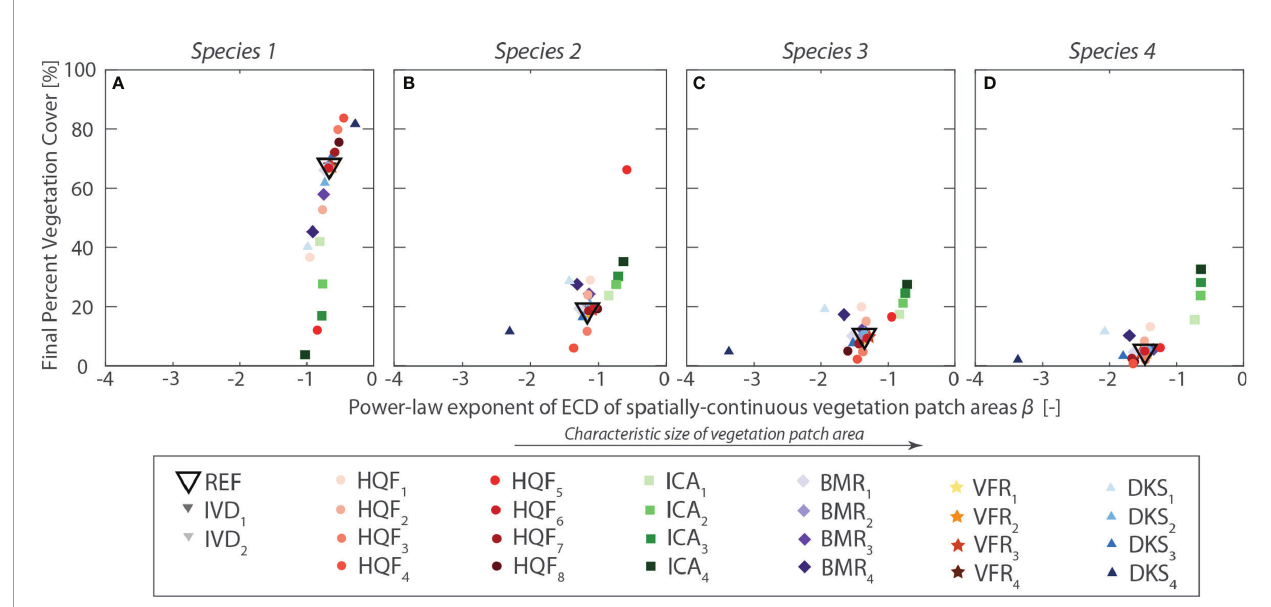
FIGURE 8 | Summary of sensitivity analysis. For each scenario explored in the sensitivity analysis, the average percent cover at the end of the numerical simulation is plotted against the power-law exponent ( b ) of the exceedance probability of vegetation patch. Panel (A – D) show the results for virtual Species 1 to 4, respectively. Different symbols denote different simulation series, whereas different colors are used to differentiate between different scenarios within each simulation series, as indicated in the lower